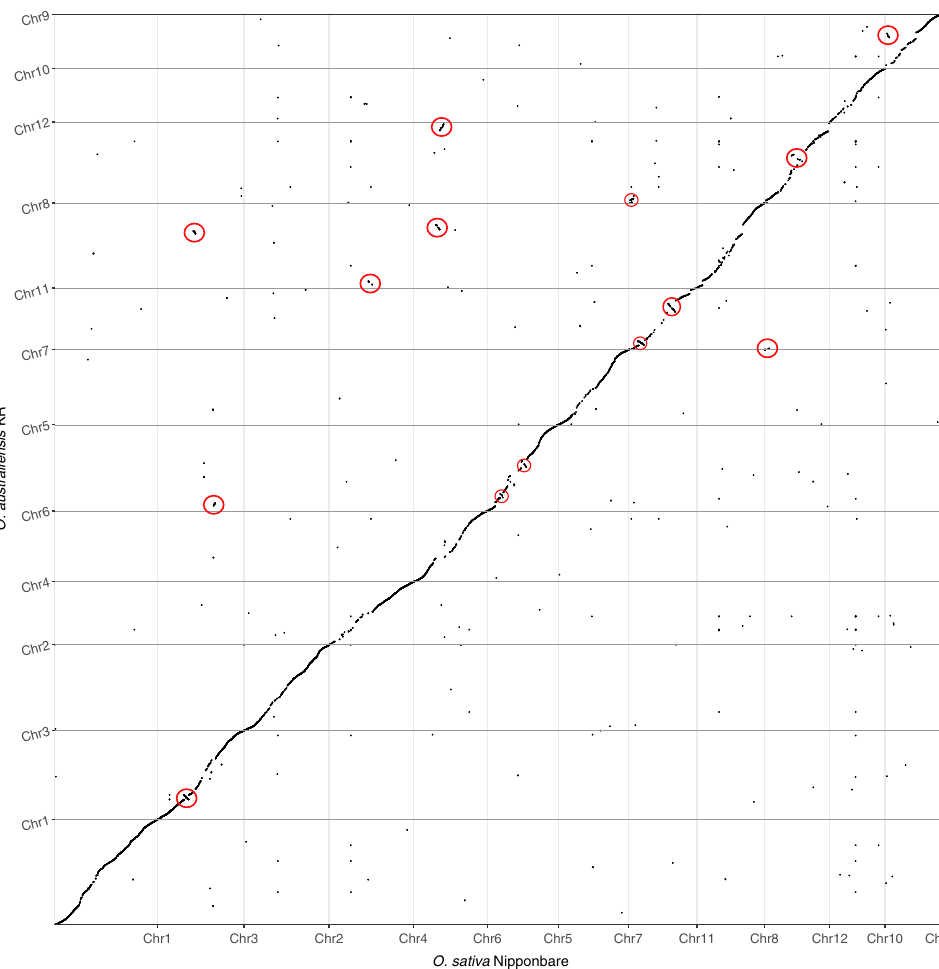
Figure 2. Alignment of scaffolded O. australiensis KR contigs (named Chr1–12) to the O. sativa Nipponbare reference genome. The wild rice genome was aligned to the domestic rice genome using minimap2 and visualised using dotplotly . The 21 SVs that were investigated further are circled in red (some circles contain multiple SVs). Note: chromosomes do not appear in numerical order— dotPlotly orders the target sequence ( O. sativa , here) by chromosome size; ChrUn is not included as it did not contain any large